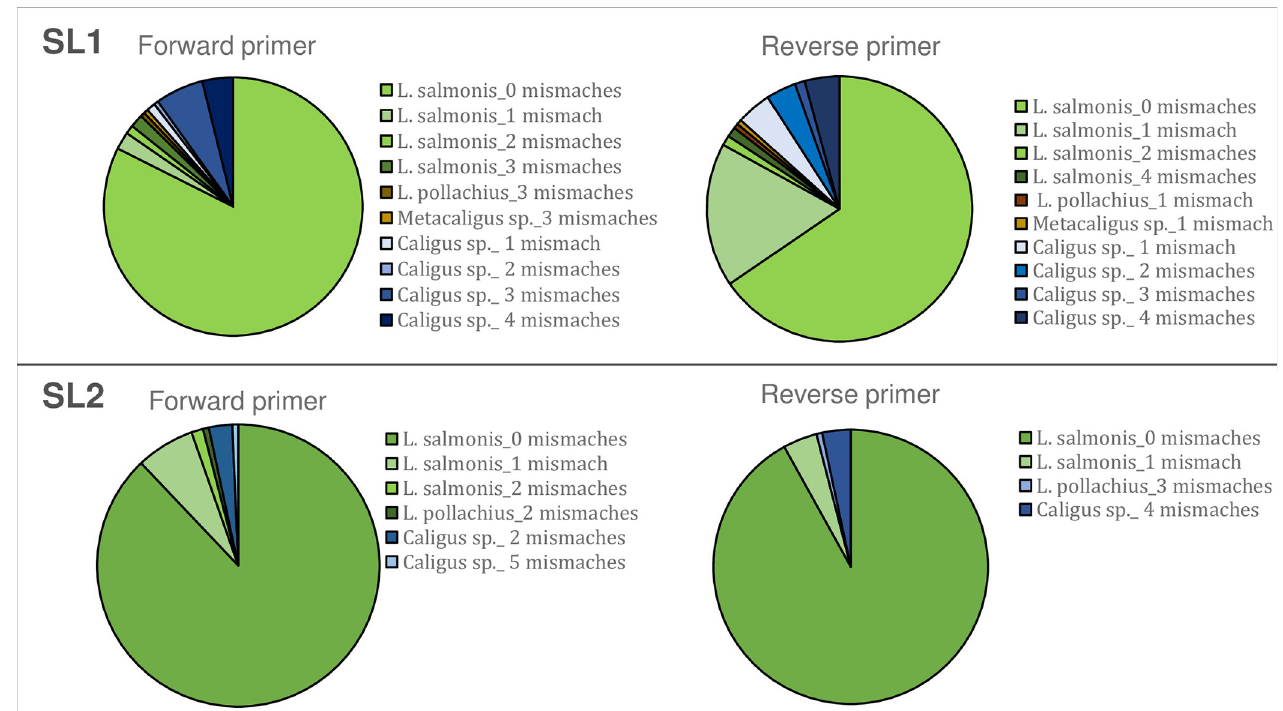
Fig 1. Specificity of SL1 and SL2 assays, a result of Primer-BLAST search. The figure includes hits up to 5 mismatches within the last 5 bps at the 3’ end.